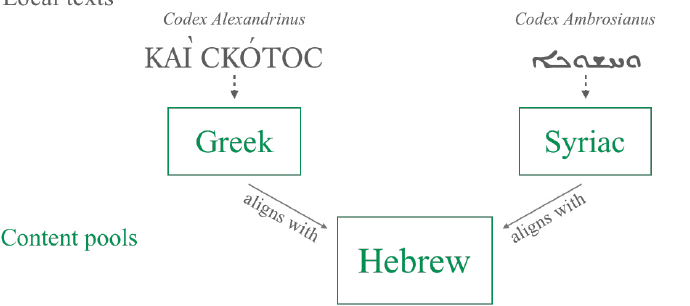
Figure 12: Comparing Greek and Syriac local texts through their alignment with the Hebrew content